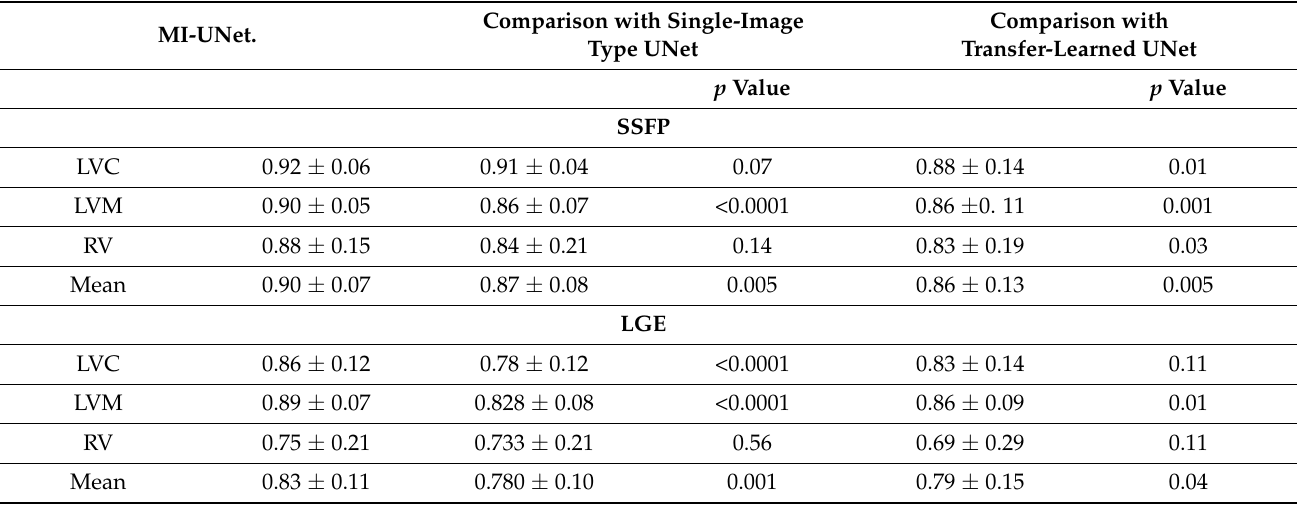
Table 3. Comparison of Dice Similarity Coefficients for Tested Models in Each Segment.